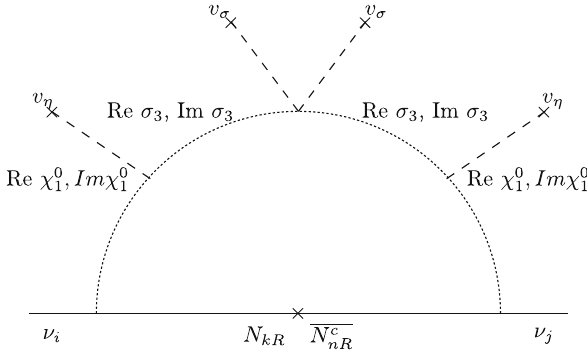
Fig. 5 One-loop Feynman diagram contributing to the entries of the light active neutrino mass matrix. Here i , j , k , n = 1 , 2 , 3